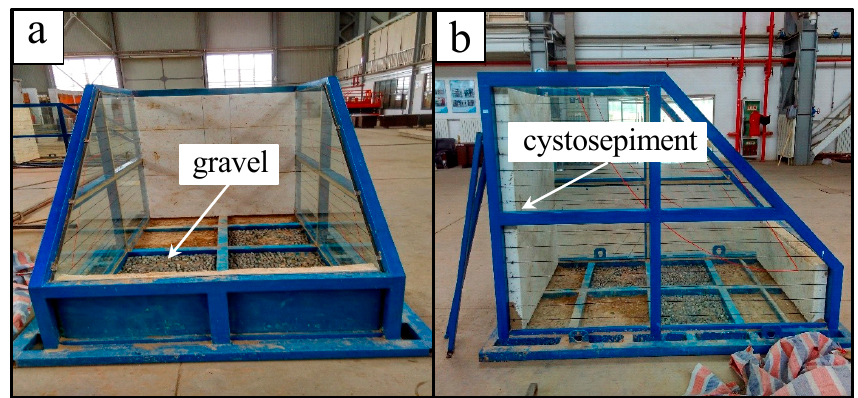
Figure 3. Model box ( a ) positive view; ( b ) lateral view.